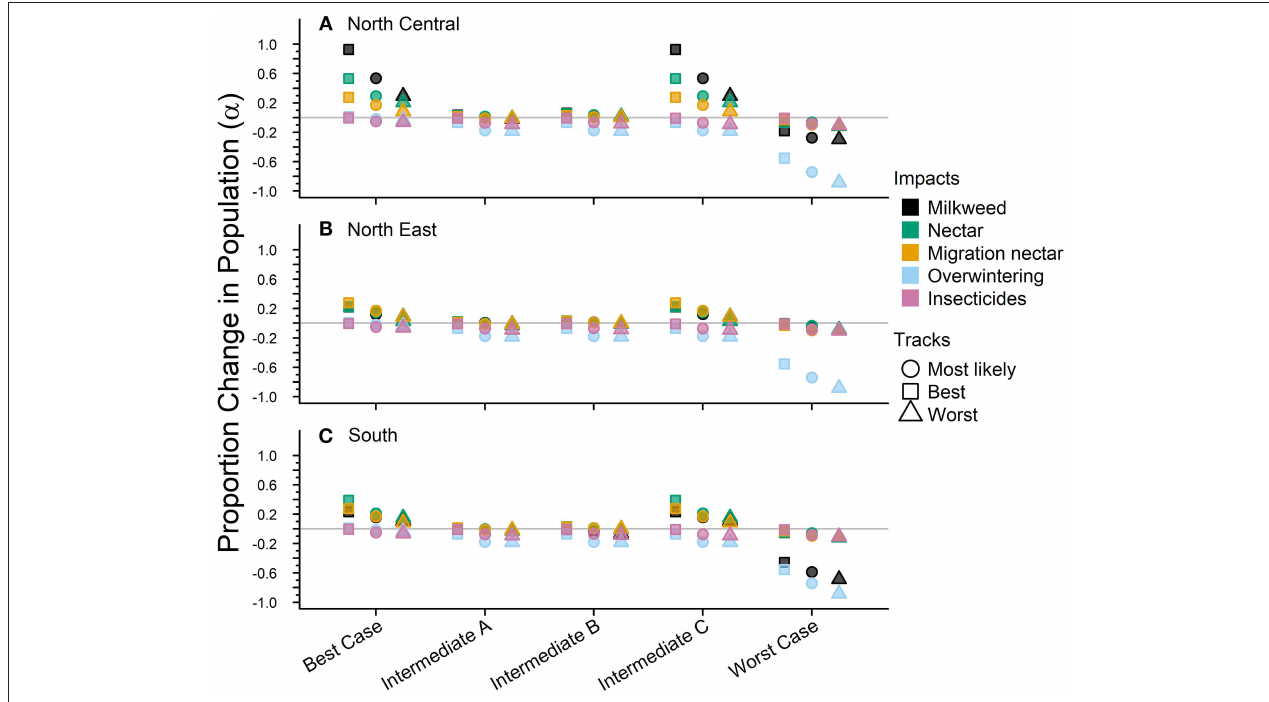
FIGURE 4 | The impacts from future drivers in the eastern monarch population as predicted by our model. Impacts are split across the three sub-regions for this population (A–C) . The impact is represented by a magnitude change above or below baseline lambda estimates and grouped by scenario along they x-axis. The colors represent the specific impacts and shapes represent the three expert elicited tracks created for each scenario (see